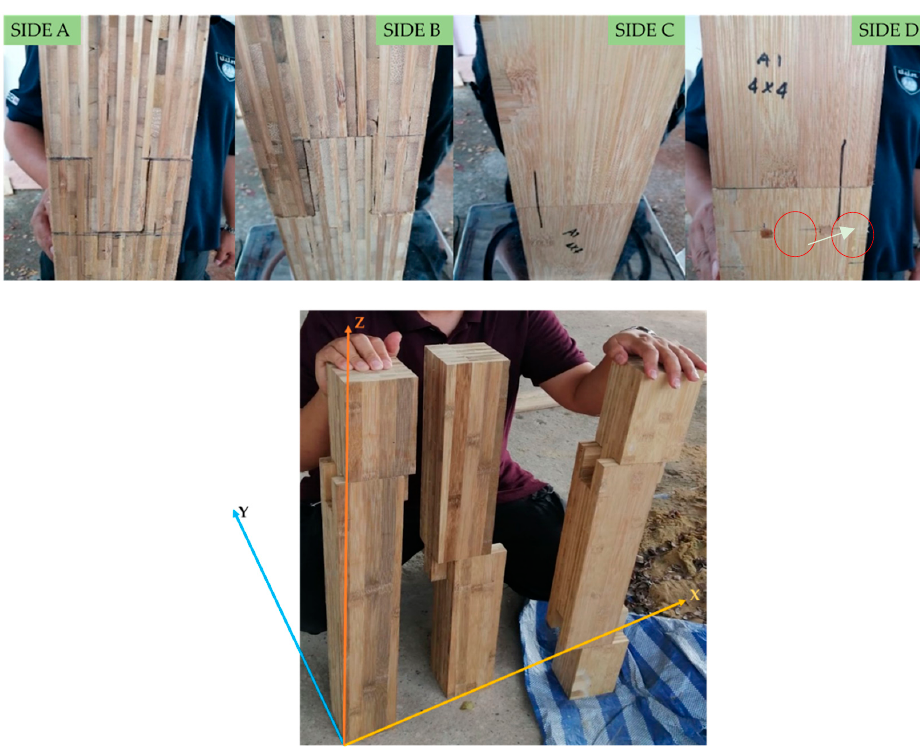
Figure 2. Column details: 4-side plan and xyz coordination.